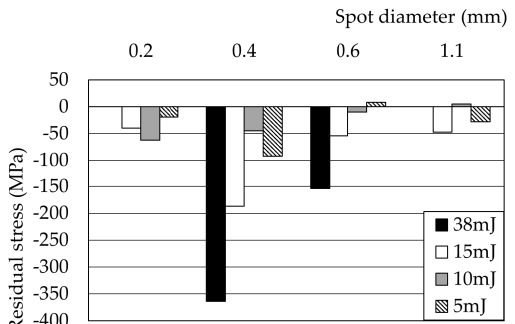
Figure 10. Comparison of surface residual stress.